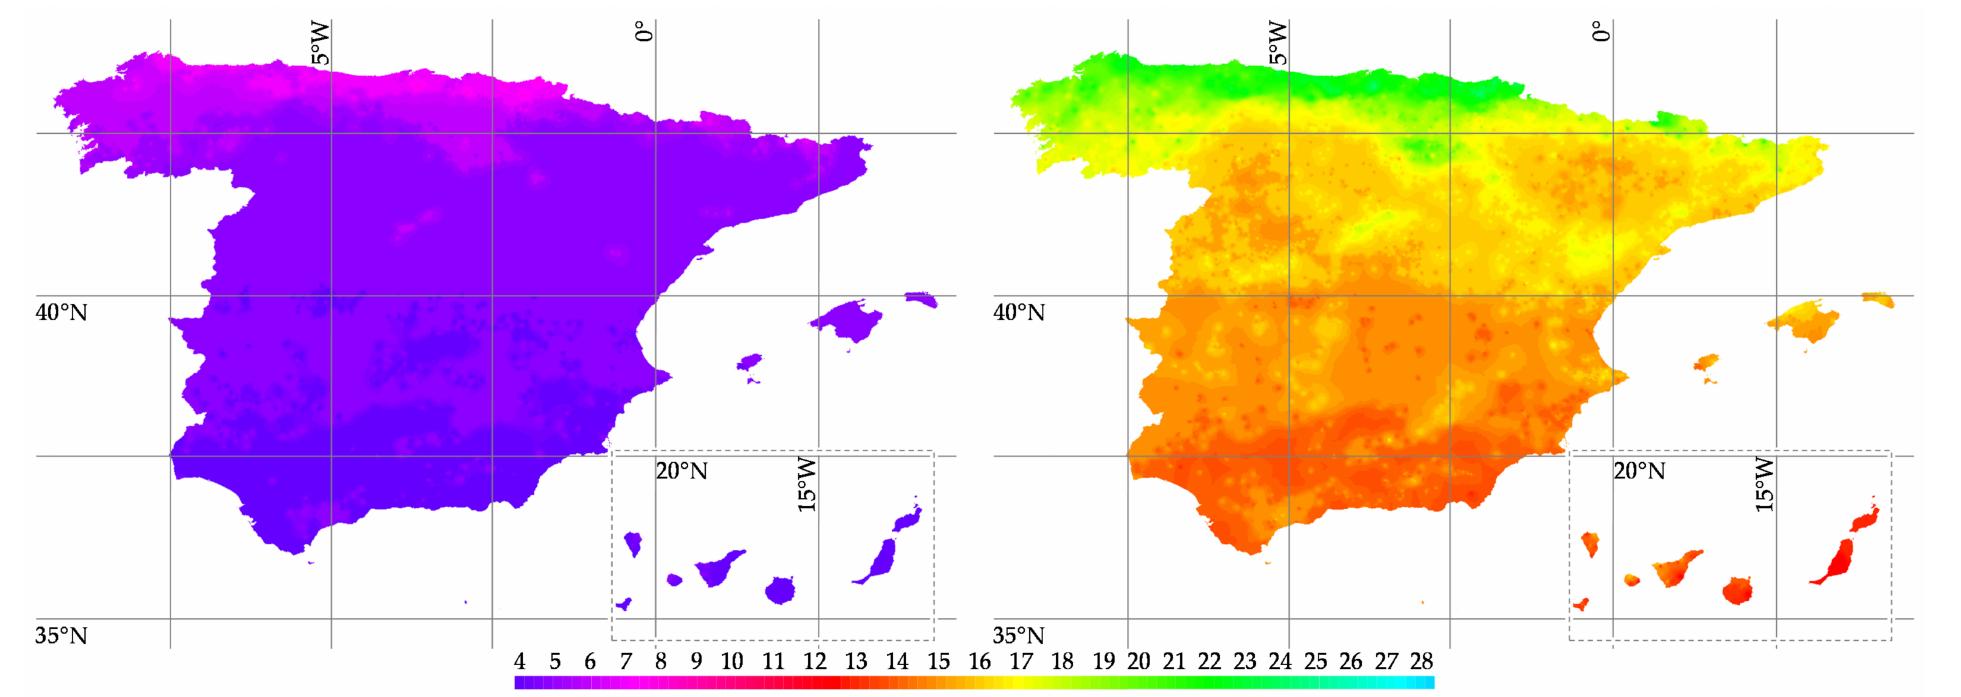
Figure A2. PV PB in years (S1 (consumption saving scenario) left , and S2 (surplus sale scenario) right ).